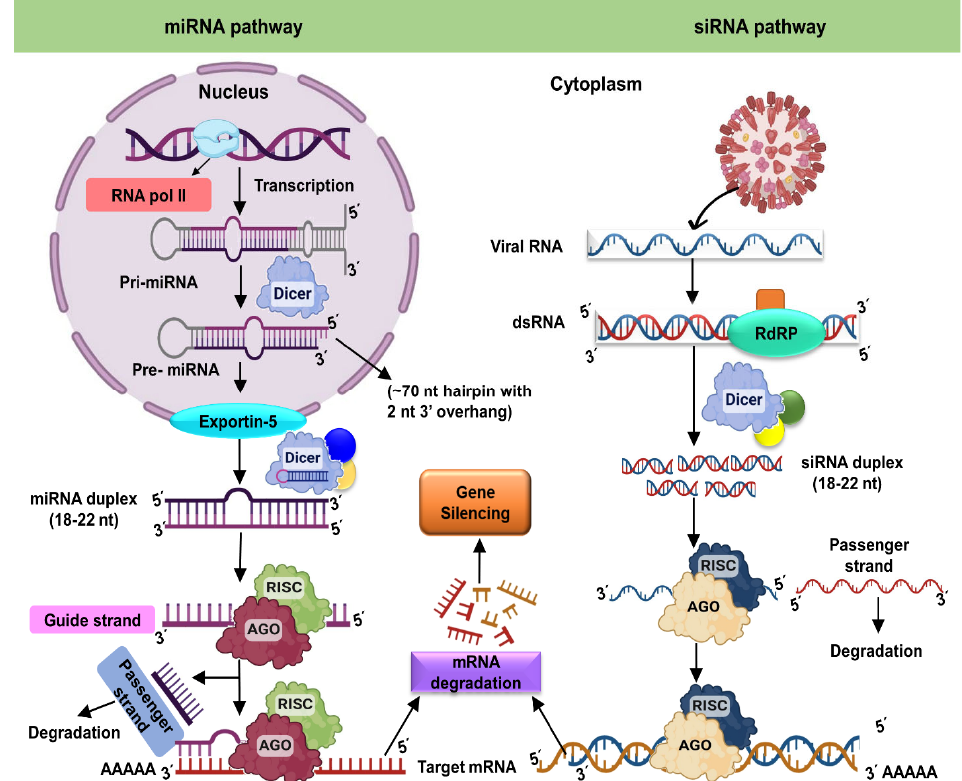
Figure 1. Mechanism of RNA interference in plant cells. The miRNA pathway, on the left, starts in the nucleus via transcription, resulting in the helix folding primary miRNA (pri ‐ miRNA). Dicer first cleaves the pri ‐ miRNA in the nucleus to produce the precursor miRNA (pre ‐ miRNA), which Dicer then cleaves to produce the roughly 22 ‐ nucleotide miRNA duplex. The duplex is transported into the cytoplasm and loaded into the RISC. In RISC, one strand of the miRNA duplex (the passenger strand) is eliminated while another strand (the guide strand) is maintained. When the RISC ‐ bound guide RNA attaches to a target RNA, it causes cleavage or translational arrest. When a target RNA (typically a structural aberrant RNA or those from an infected plant virus, as in this case) is detected by Dicer, the target RNA is cleaved into short (21–24 nucleotide) duplex RNAs. In the case of duplex miRNAs, one strand (the passenger) is delivered and degraded while the other (the guide RNA) is maintained by RISC. Cleavage occurs whenever the RISC ‐ bound guide RNA attaches to a target RNA. The RNAi response within the cell can be amplified by RNA ‐ dependent RNA polymerase activity. AGO: Argonaute protein; DCL: Dicer ‐ like protein; RISC: RNA ‐ induced silencing complex; RdRP: RNA ‐ dependent RNA polymerase; RNAi: RNA interference.